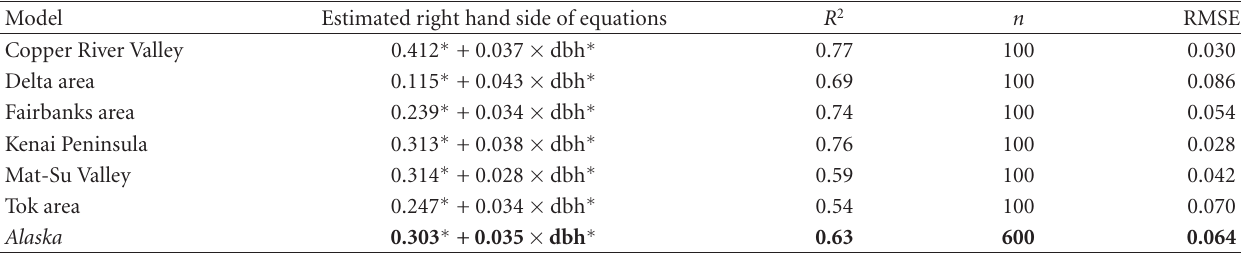
Table 2: Parameters of the six area models and the statewide model to estimate the bark thickness of white spruce in Alaska northern forests.